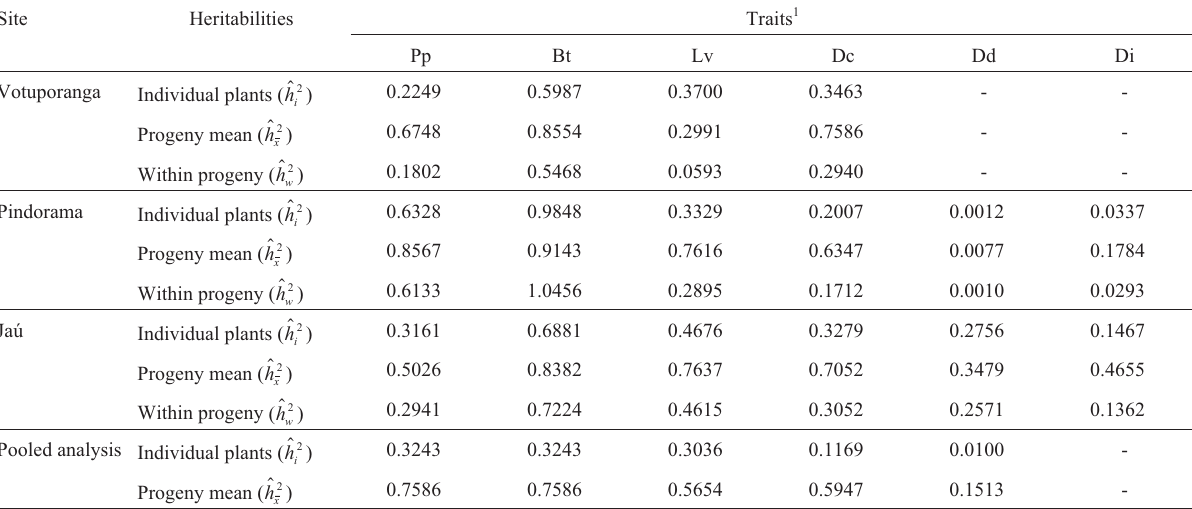
Table3 -Heritabilitycoefficientsforsixdifferentlaticiferoussystemtraitsof22three-year-oldopen-pollinated Hevea progeniesgrowingatthreesitesin the Brazilian State of São Paulo.